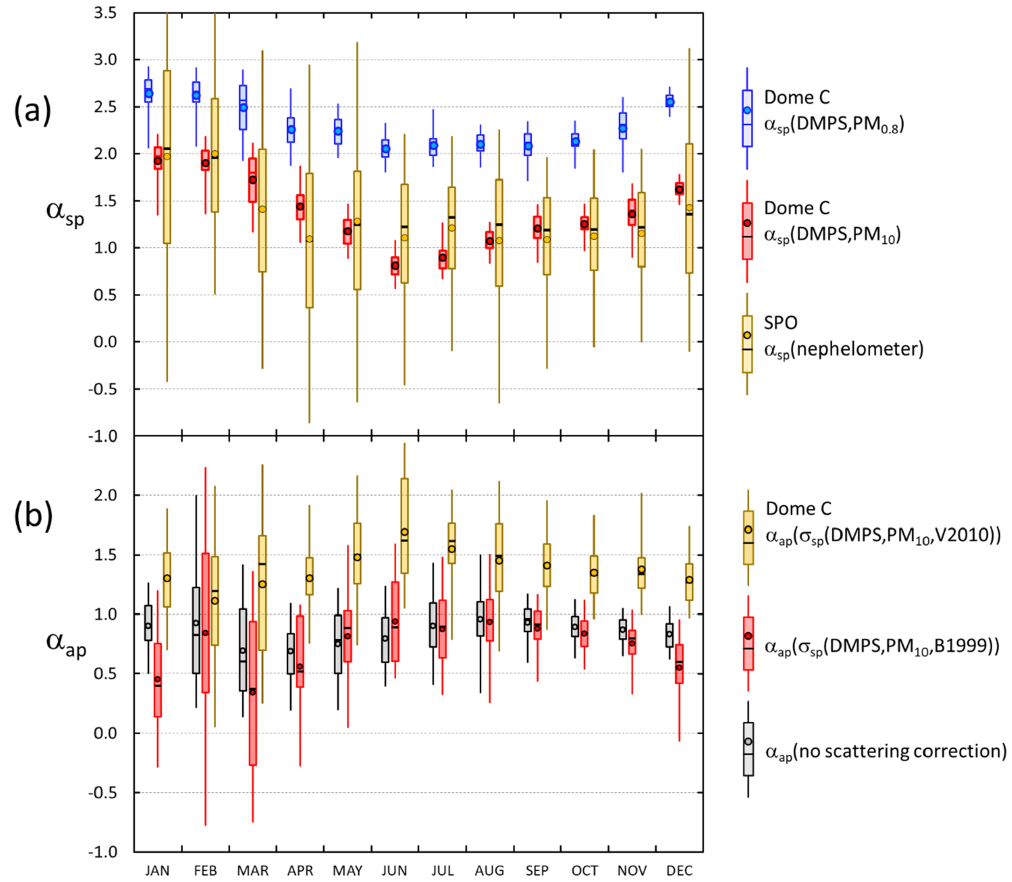
Figure 10. Seasonal cycles of the wavelength dependency of (a) scattering and (b) absorption. In panel (a) the Ångström exponent α sp was calculated from the size distributions measured at Dome C ( σ sp (DMPS,PM 0 . 8 ) and σ sp (DMPS,PM 10 ) for the wavelength range 467–660nm and measured at the South Pole Station with a nephelometer. The SPO α sp was calculated for the wavelength range 550–700nm. In panel (b) the absorption Ångström exponent α ap was calculated for the σ ap without scattering correction and by using the B1999 and V2010 algorithms with scattering corrected using σ sp = σ sp (DMPS,PM 10 ). In all of them the data with σ ap > 3 δσ ap were